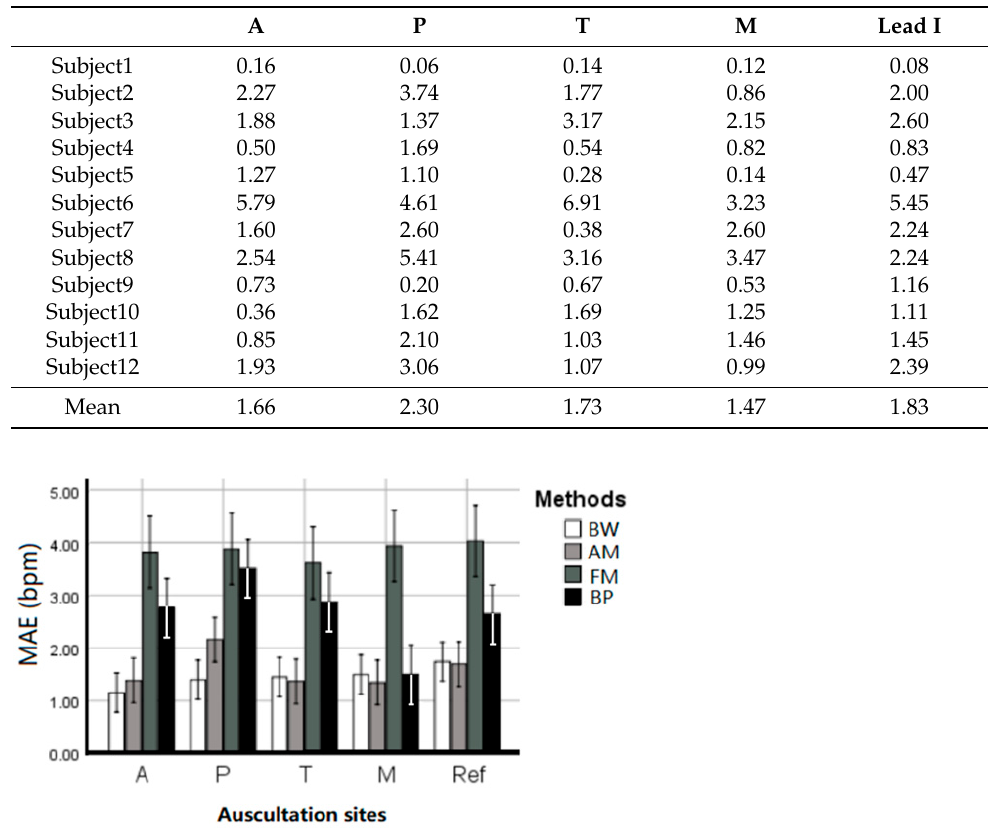
Figure 5 further visualized the location effect with different algorithms. Table 1. The ECG-derived respiration (EDR) mean absolute errors (MAE) of each subject for each auscultation site and Lead 1 ECG signals, averaged across estimation techniques.